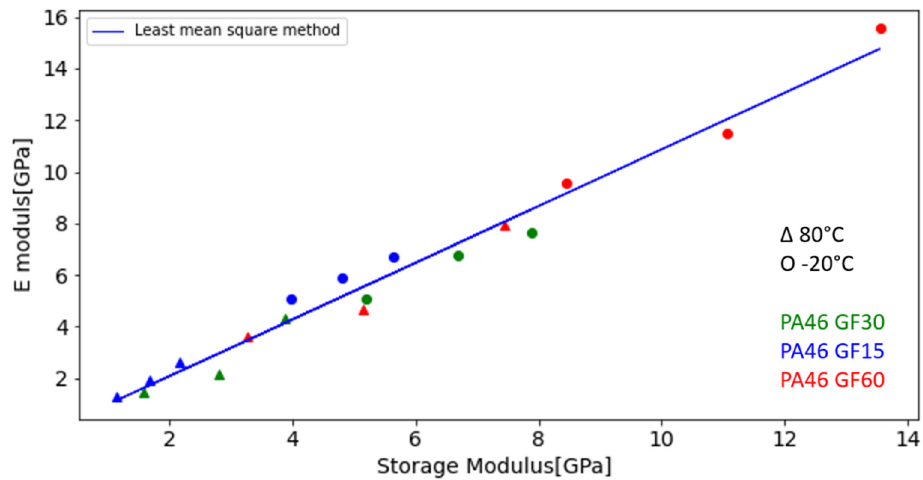
Figure 4. Experimental Young´s modulus plotted on the scale of the storage modulus of correspond- ing material data.